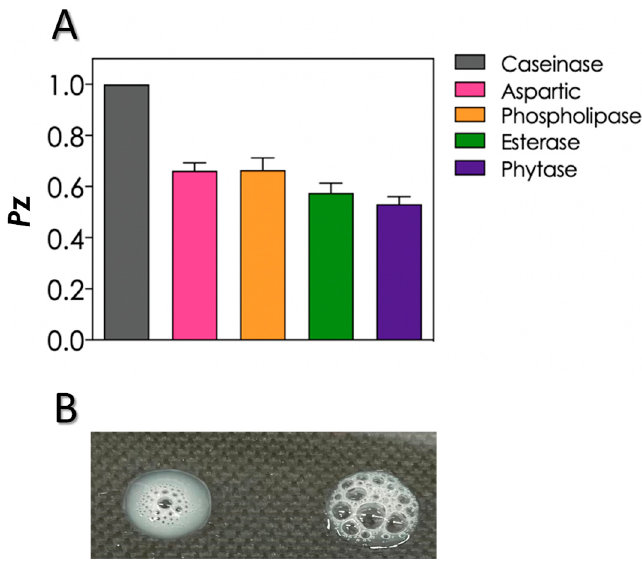
Figure 2. Extracellular molecules produced by S. cerevisiae HUPE-Sc1 strain by means of agar plates containing specific substrates to detect: caseinase, aspartic peptidase, phospholipase, esterase and phytase ( A ), and catalase activity demonstrated by the formation of bubbles after the contact of S. cerevisiae HUPE-Sc1 strain with H 2 O 2 , which correspond to the hydrolysis of H 2 O 2 in water and molecular oxygen ( B ). The results represent means ± standard deviation of three independent experiments.